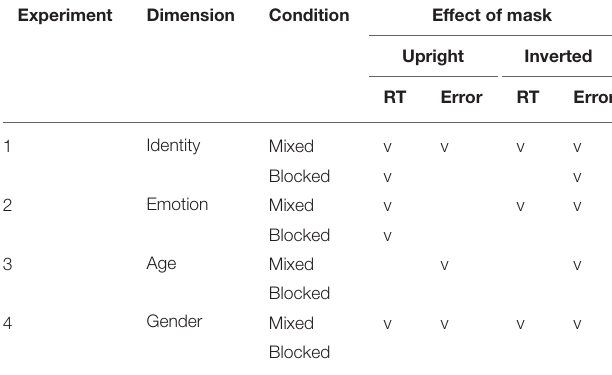
TABLE 1 | Summary: Effects of masks on categorization of faces in the four